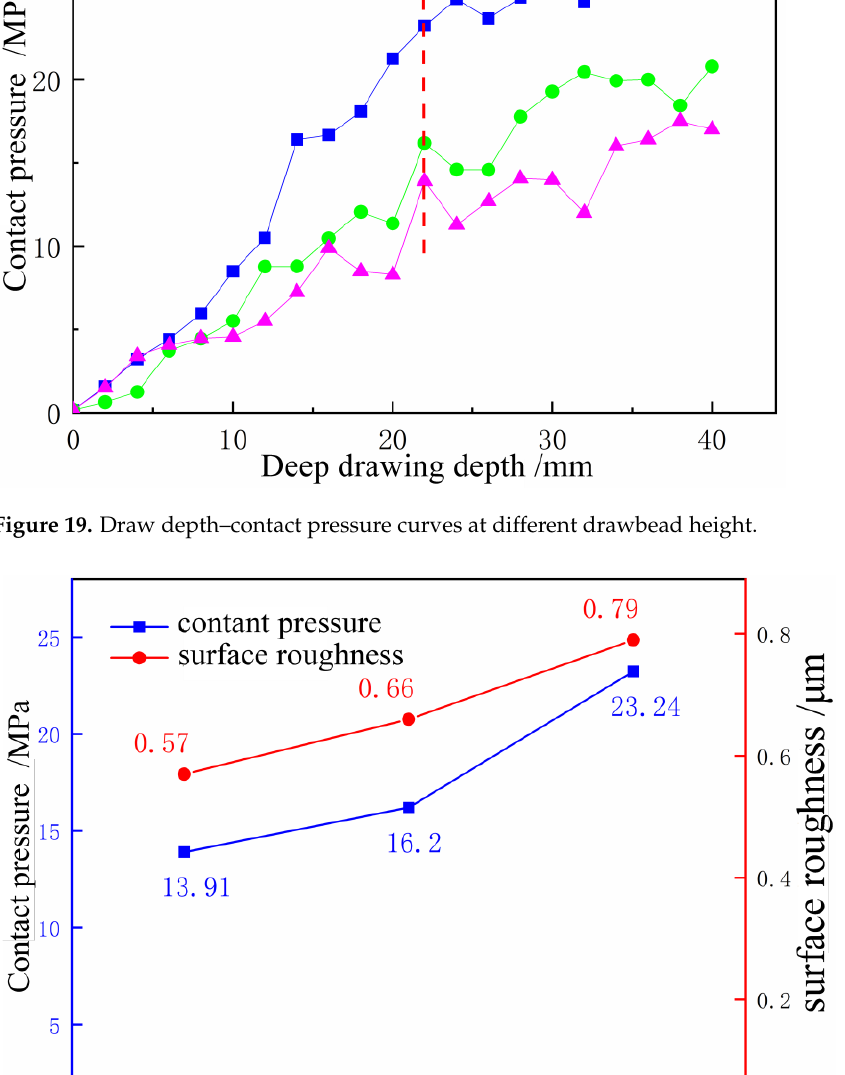
Figure 21. Skid line display at different drawbead height.